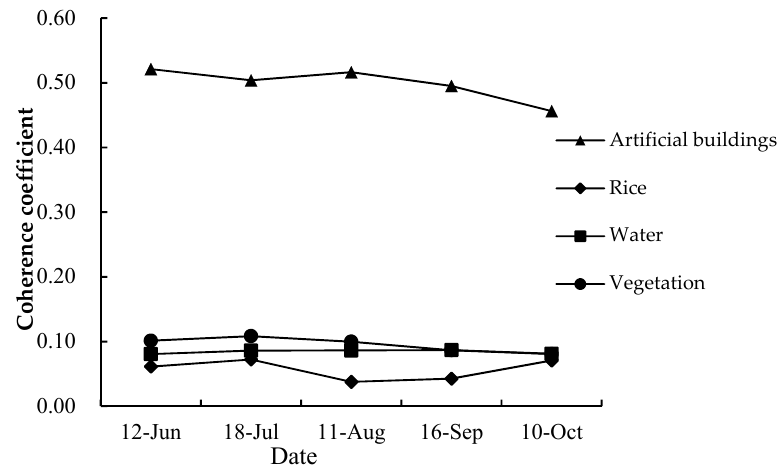
Figure 13. Sentinel-1 VV polarization coherence coefficient map. Table 3. Coherence coefficient of ground objects of VV polarization.